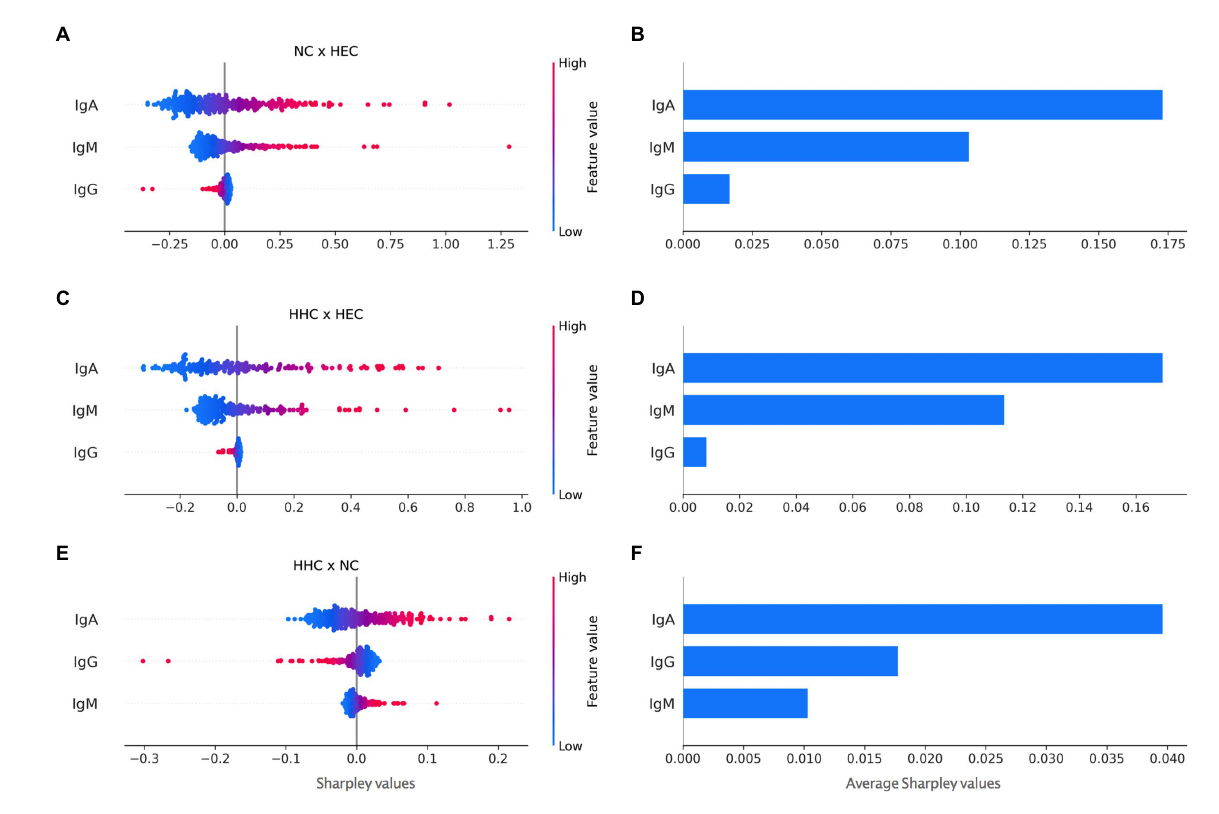
FIGURE 3 Contrasting Shapley values for impact on HD diagnosis for all antibodies against Mce1A protein. Each marker in the scatter plots corresponds to an individual and red to blue shades correspond to negatives to positive Shapley values (A, C, E) . The scatter plots expose not only the importance of a potential risk factor for HD diagnosis but also its range of effects over the NC and HEC (A) , HHC and HEC (C) , HHC and NC (E) groups. Scatter plots (B,D , and F) showed average Shapley values for the respective comparisons. HEC, healthy endemic controls; HHC, household contacts of HD patients; NC, new cases of HD; IgA, immunoglobulin A; IgM, immunoglobulin M; IgG, immunoglobulin G.